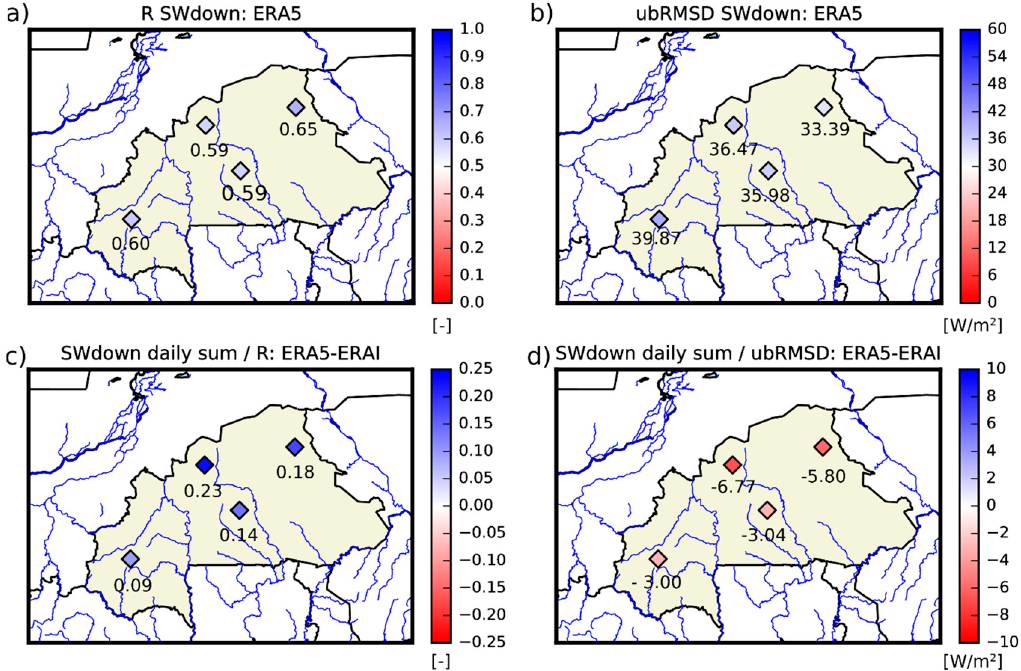
Figure 4. Maps of correlation R ( a ) and ubRMSD ( b ) between incoming solar radiation time series from ERA5 and in situ measurements. ( c , d ) represent the difference between ERA5 and ERA- Interim in correlation and ubRMSD for 2017, respectively. For each station presenting significant R ( p values < 0.05), the simulation that presents the better R values is represented.